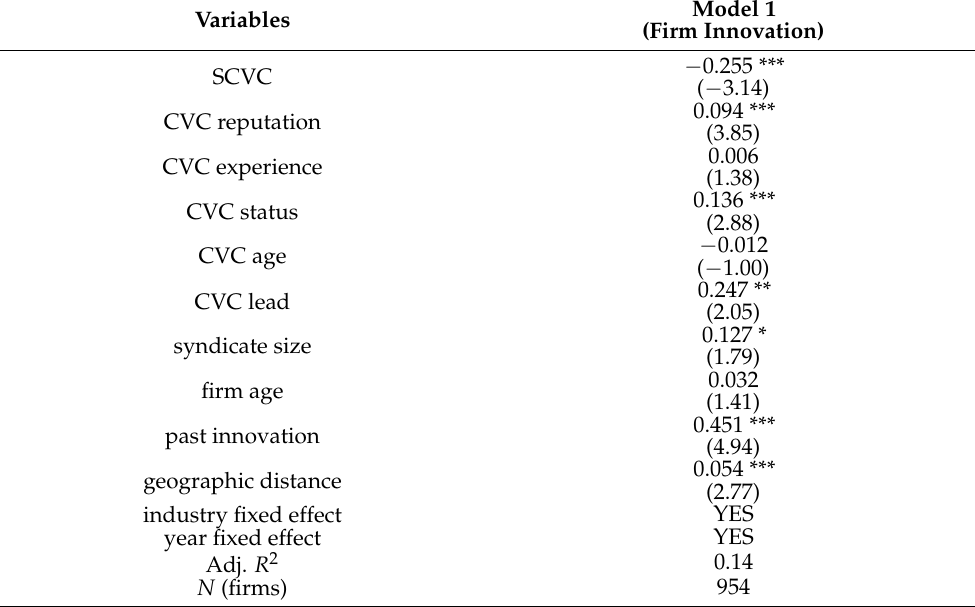
Table 3. The innovation differences between SCVC-backed and PCVC-backed